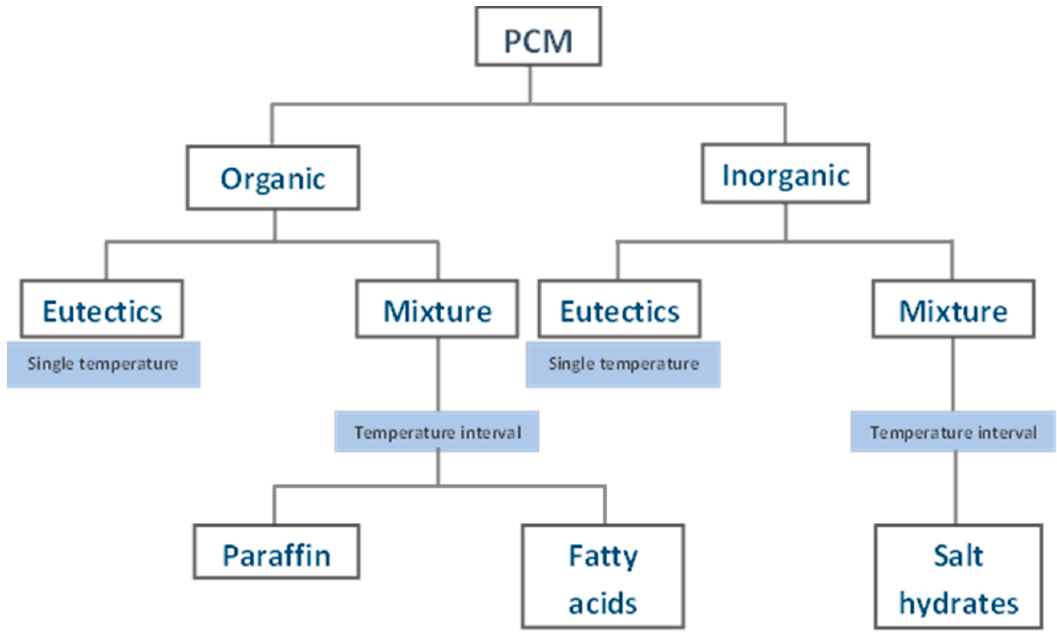
Figure 1. PCM classification adapted from Abhat [8] regarding the PCM type available within the temperature range of 20 to 30 °C.